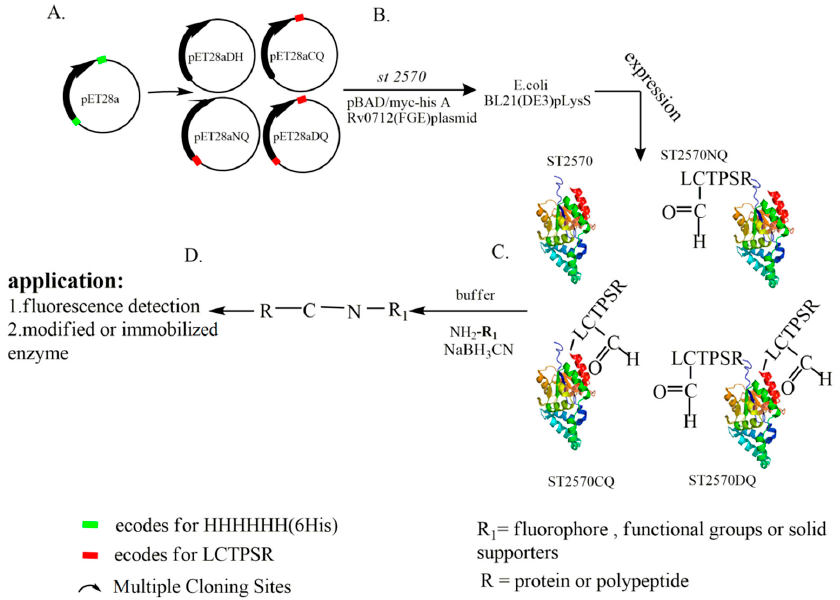
Scheme 1. Schematic of the E. coli co-expression system used for the aldehyde tagging of proteins in